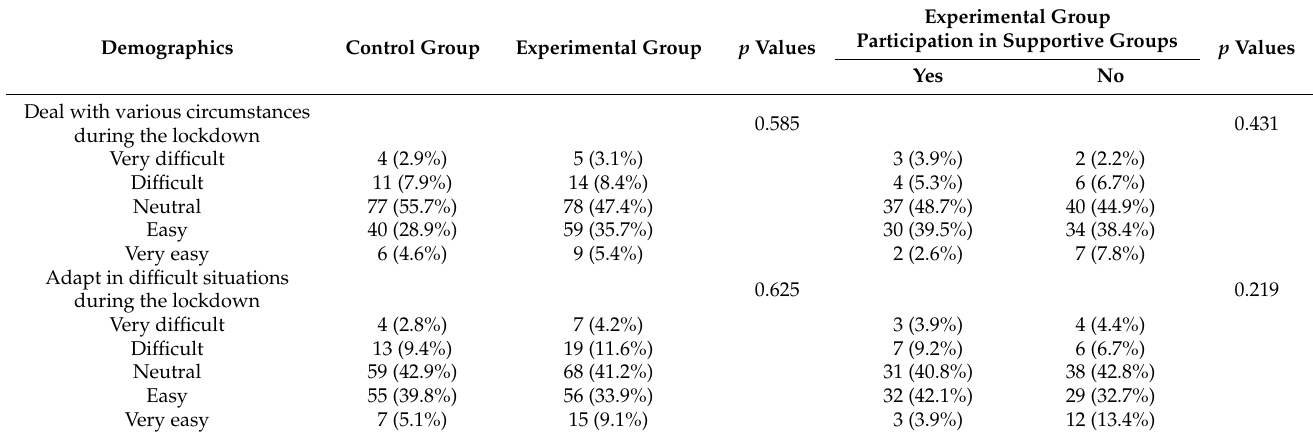
Table 8. Adaptability skills affecting participants during the pandemic.